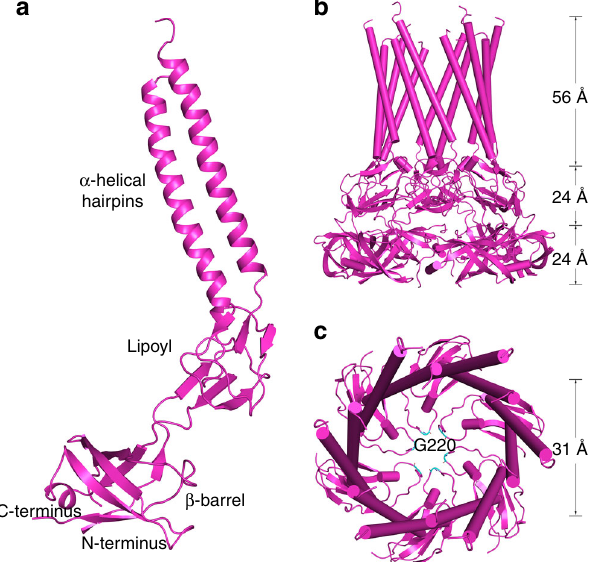
Fig. 2 Structure of Spr0693. a The Spr0693 monomer. The three domains, namely α -helical hairpins, lipoyl and β -barrel, are marked. b Side-view of Spr0693 hexamer. Six α -helical hairpins, shown in cylindrical helices, pack against each other to form an α -helical barrel. c Top-view of Spr0693 from the α -helical barrel, with a diameter of ~31 Å. A gating ring is formed by the fl exible loops from the lipoyl domains, with six Gly220 residues at the